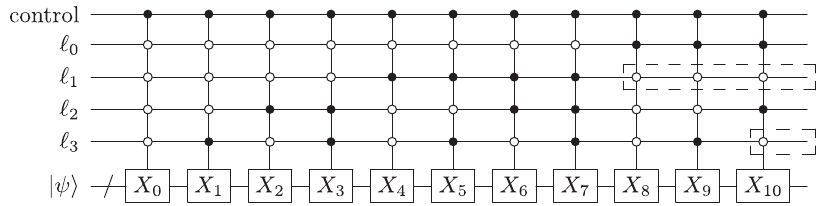
FIG. 3. Example total control circuit for performing a controlled indexed X l operation, with 0 ≤ l < L ¼ 11 . This is the (naive) starting point for producing a unary iteration circuit, before optimizations that asymptotically improve the T complexity. When indices outside the specified range do not occur, the highlighted runs of OFF -type controls reaching the right-hand side of the circuit can be removed without affecting the circuit. (There are also other controls that could be removed, but for our purposes, this would be counterproductive because it would interfere with later